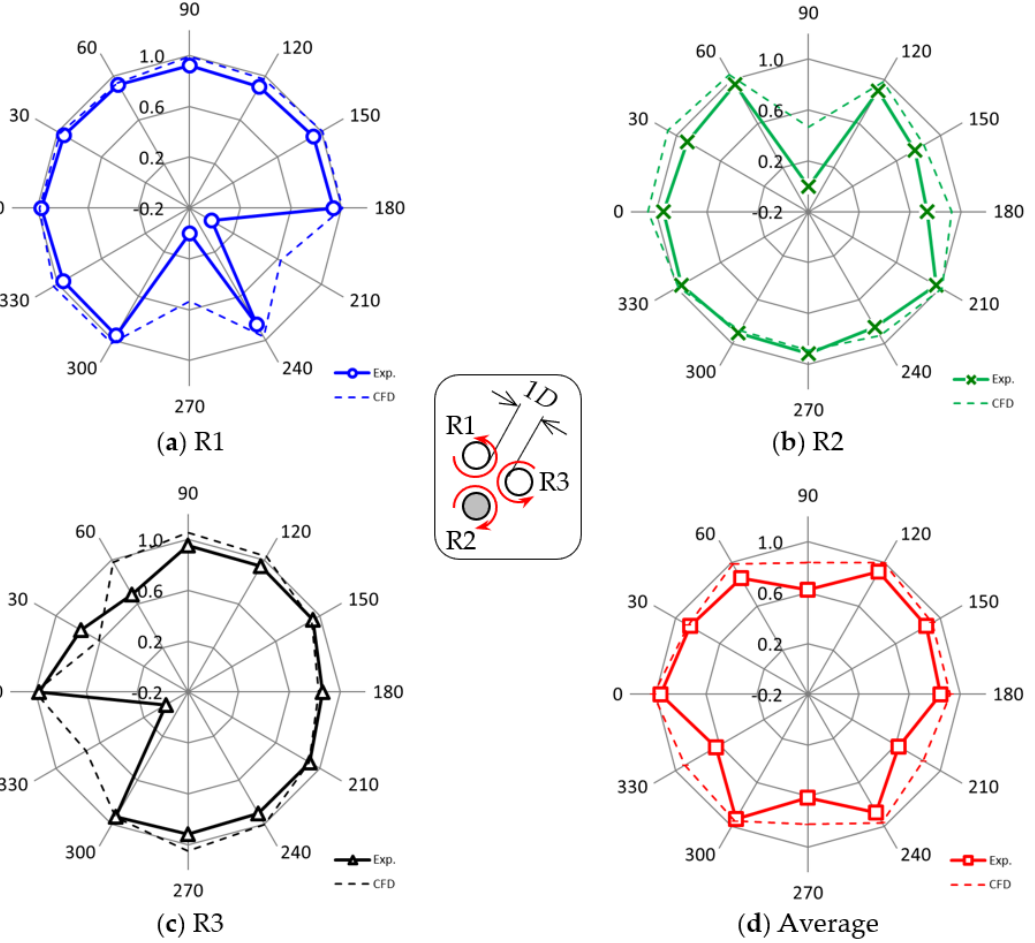
Figure 20. Comparison between the experimental and CFD results on 12-wind-direction dependence of normalized rotational speed in a trio of VAWT models at g / D = 1 in the 3IR configuration: